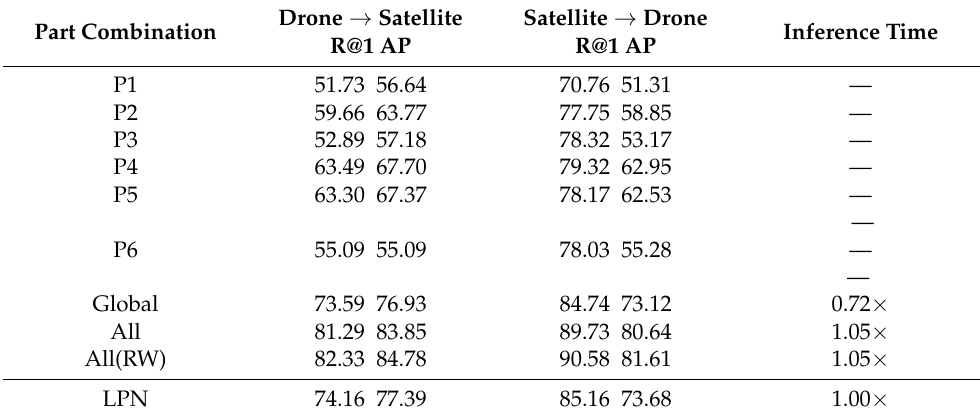
Table 7. Results of ablation experiments of using different parts during inference. “P1–P6” means using only one part in Figure 4. “Global” means only using global branch. “ALL” means the com- bination of all of them. “RW” means reweights.